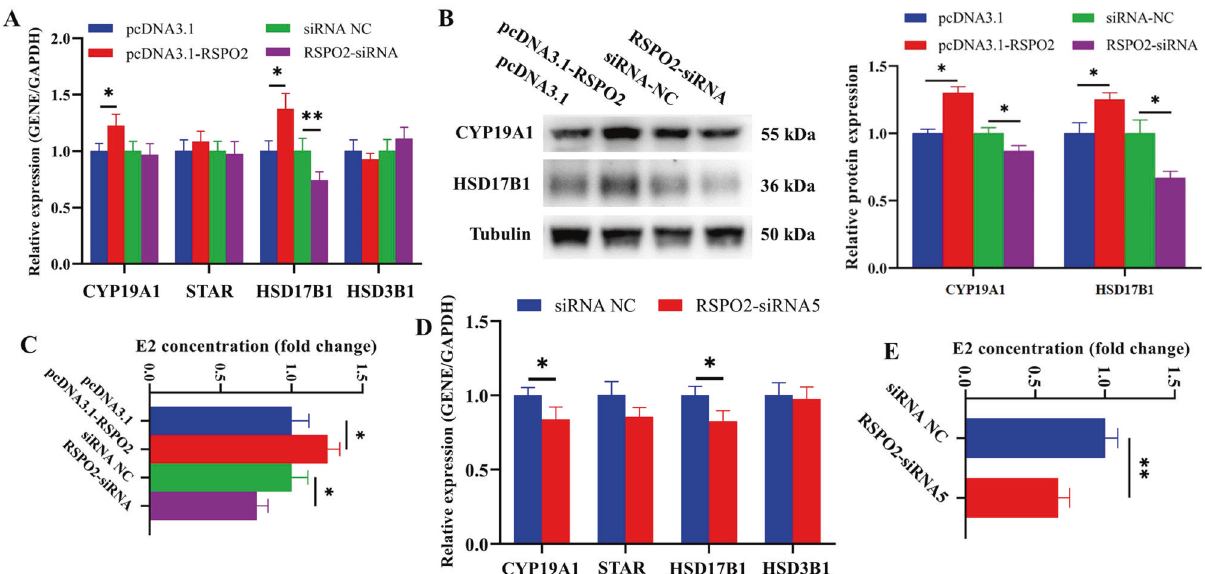
Fig. 4 RSPO2 promoted the secretion of E2 in porcine ovarian GCs. A, B The mRNA ( A ) and protein ( B ) expression levels of CYP19A1 , STAR , HSD17B1 , and HSD3B1 in porcine GCs with RSPO2 overexpression and inhibition. C The concentration of E2 in porcine ovarian GCs with RSPO2 overexpression and inhibition were assessed by ELISA. D The mRNA expression levels of CYP19A1 , STAR , HSD17B1 , and HSD3B1 in porcine GCs transfected with RSPO2 -siRNA5. E The concentration of E2 in porcine ovarian GCs transfected with RSPO2 -siRNA5 was assessed by ELISA. * P < 0.05, ** P <